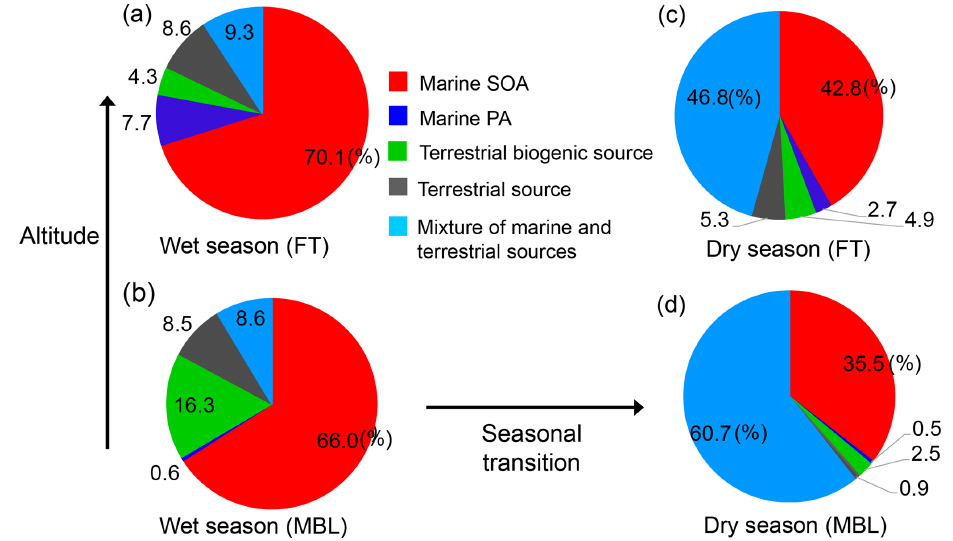
Figure 9. Average contribution of each PMF-derived factor to the WSOC mass concentration during the wet season (a, b) and dry season (c, d) . The pie charts are further classified under (a, c) FT and (b, d) MBL